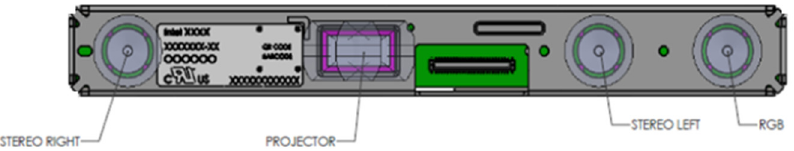
Figure 1. The component locations inside the RealSense D415 camera.